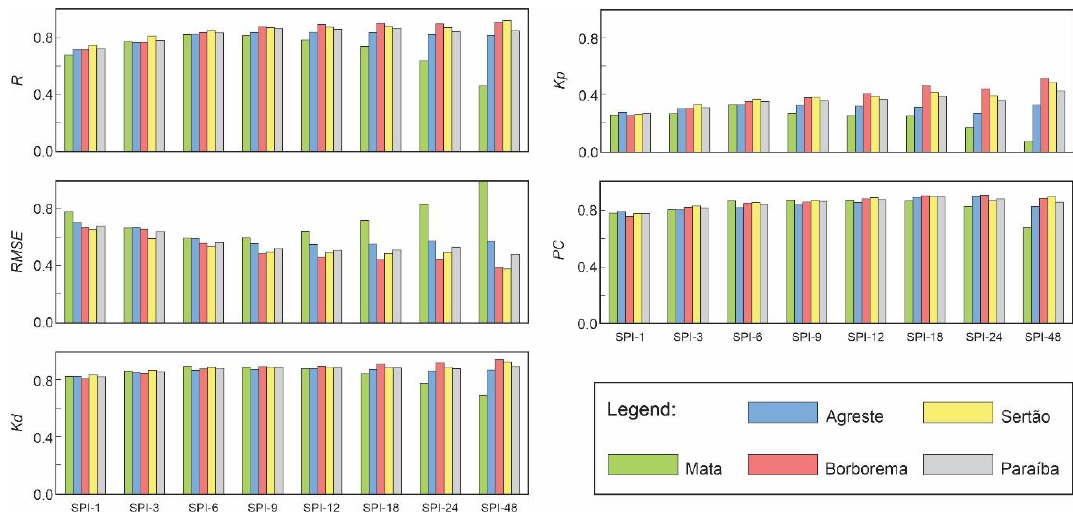
Figure 8. Statistical accuracy analysis of the indices R and RMSE (group 1), Kd and Kp (group 2) and PC (group 3) for each of the mesoregions in Paraíba State (1998–2017).